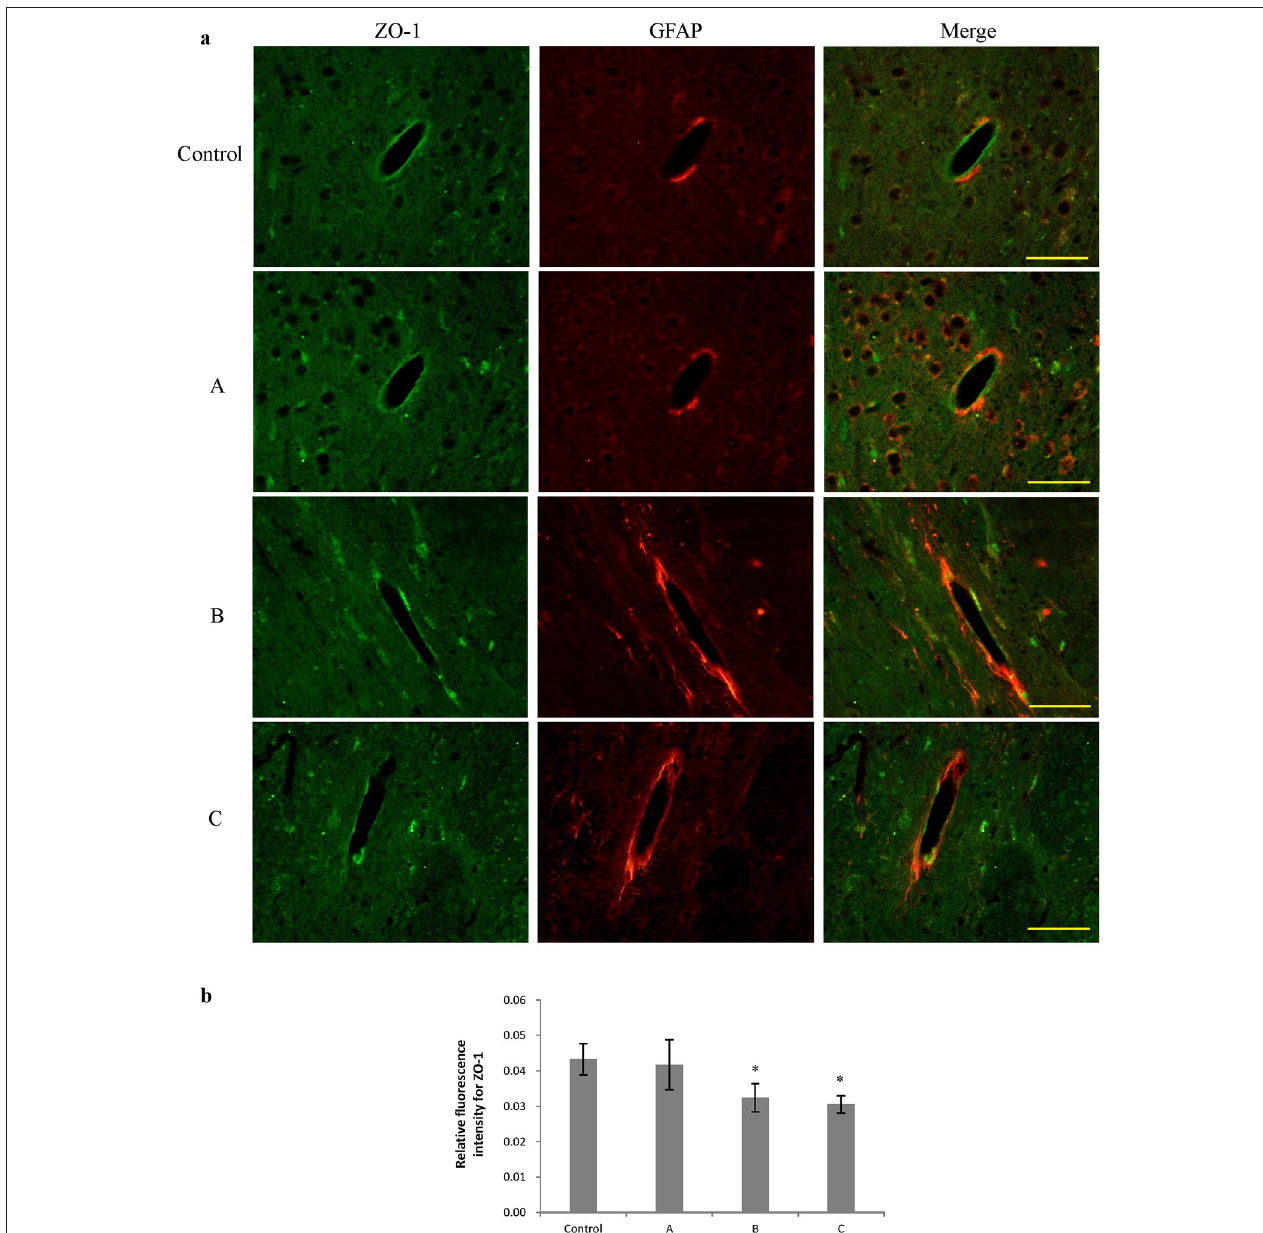
FIGURE 3 | Comparison of ZO-1 protein expression in mouse brain among groups (scale bar = 25 µ m). Five mice were selected in each group. Data were given as mean ± SD , and analyzed by one-way ANOVA. Significant difference was defined as P < 0.05, * vs. control group. (a) Immunofluorescence staining, green represented ZO-1, and red is for GFAP. A to C represented three exposure groups, in which mice were exposed to 1,2-DCE for 1, 2, or 3days. (b) Comparison of relative fluorescence intensity for ZO-1 among